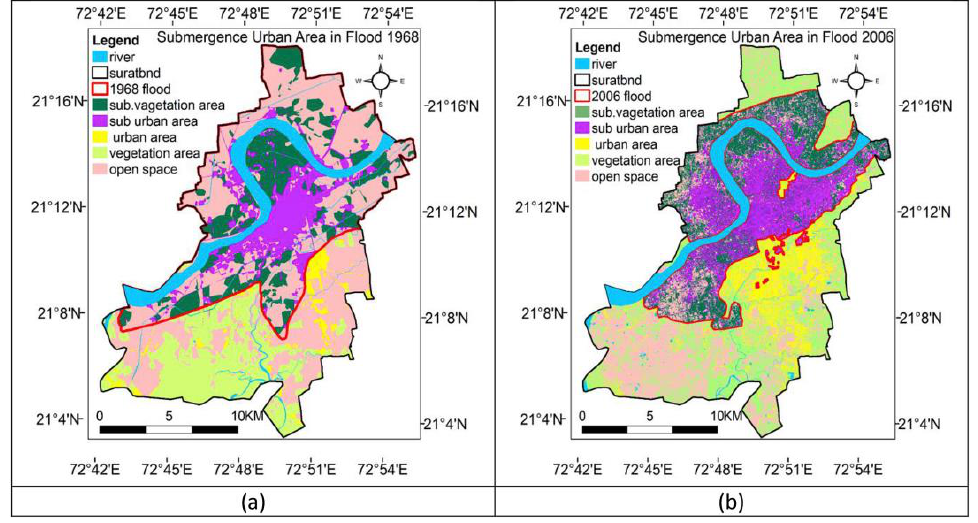
Figure 2. (a) Urban flood risk area of year 1968; (b) Urban flood risk area of year 2006